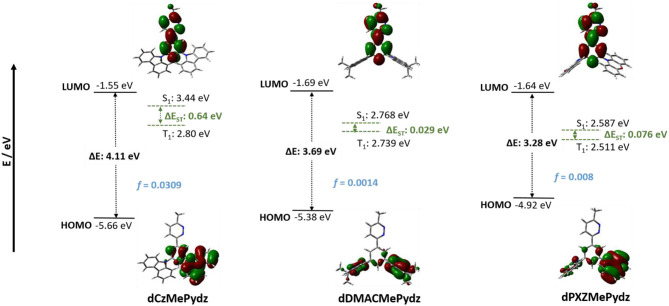
Frontier molecular orbitals (isovalue = 0.02) and corresponding energy values calculated at PBE0/6-31G(d,p) level in vacuum.